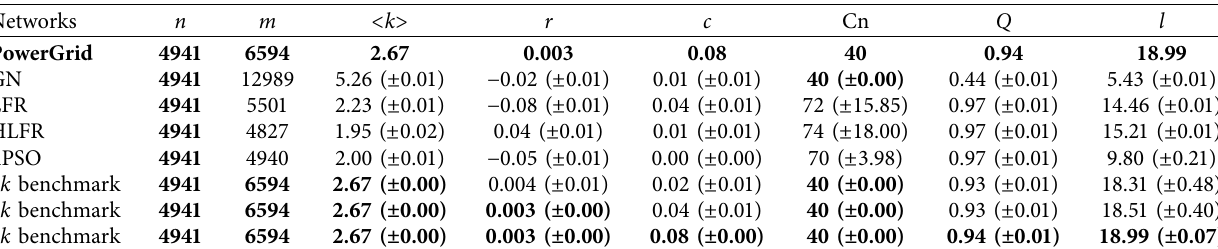
Table 3: Structural characteristics of the original PowerGrid network and seven kinds of generated benchmarks. Each data represents the average value of the characteristic calculated on 100 generated benchmarks and the data in parentheses represents the corresponding standard deviation. Note that the best results closest to the original karate network on each characteristic are highlighted in